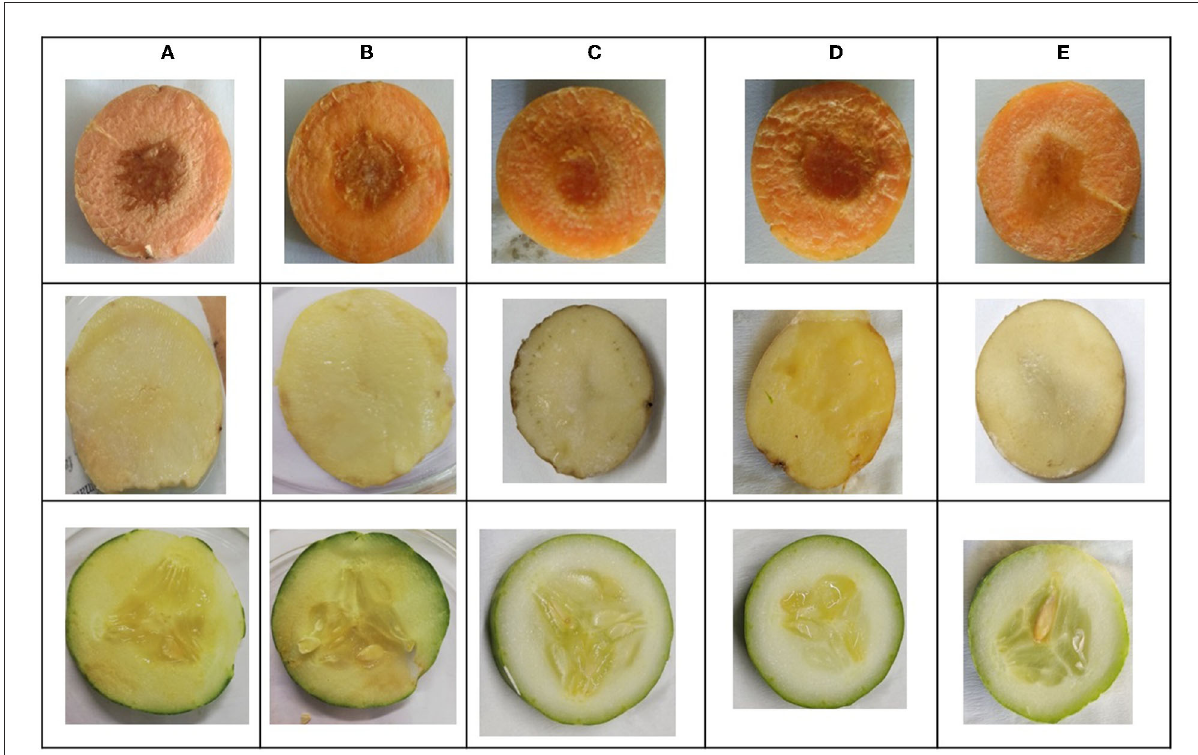
FIGURE10 In vitro soft rot attenuation assay on potato, carrot, and cucumber; (A) Lelliottia amnigena alone, (B) L. amnigena RCE + DMSO (Control, 100 µ l), (C) RB bacterial crude extract (100 µ l) + L. amnigena RCE (100 µ l), (D) L. amnigena RCE + DMSO (Control, 200 µ l), and (E) RB bacterial crude extract (200 µ l) + L. amnigena